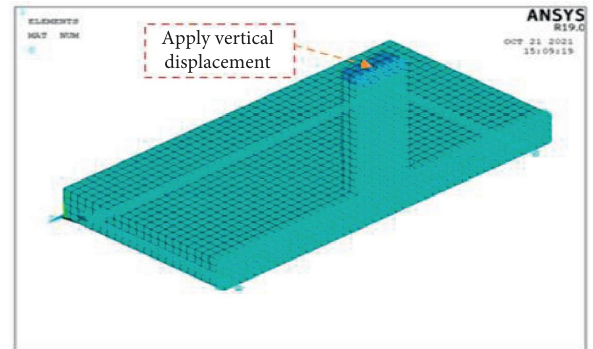
Figure 6: Geometry, meshing, loading, and boundary conditions of part-II